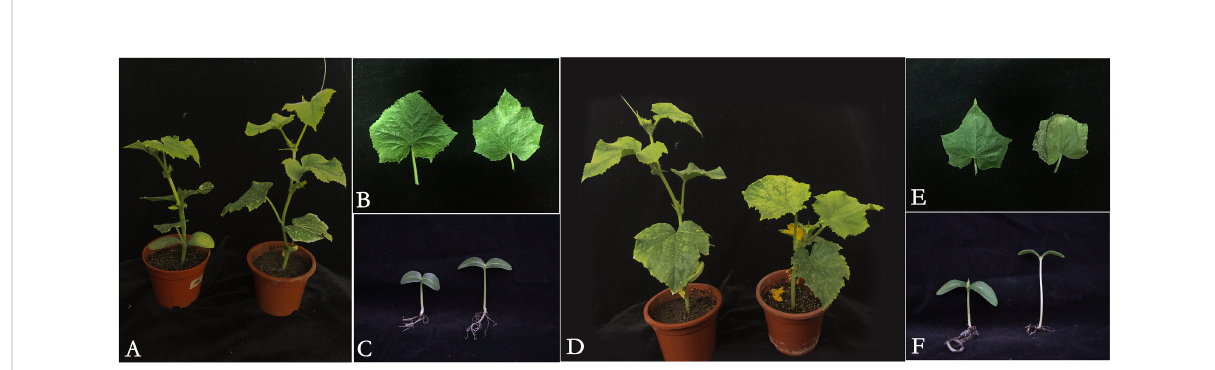
FIGURE 1 Seedling of cucumber lines with different tolerance under low-light stress. (A) The plant of low-light-tolerant line M67 under normal light and semilethal low- light stress (from left to right), (B) The leaf of low-light-tolerant line M67 seedling with two leaves under normal light and semilethal low-light stress (from left to right), (C) The hypocotyl of low-light-tolerant line M67 seedling in cotyledonous stage under normal light and semilethal low-light stress (from left to right), (D) The plant of low-light-sensitive line M14 under normal light and semilethal low-light stress (from left to right), (E) The leaf of low-light sensitive line M14 seedling with two leaves under normal light and semilethal low-light stress (from left to right), (F) The hypocotyl of low-light-sensitive line M14 seedling in cotyledonous stage under normal light and semilethal low-light stress (from left to